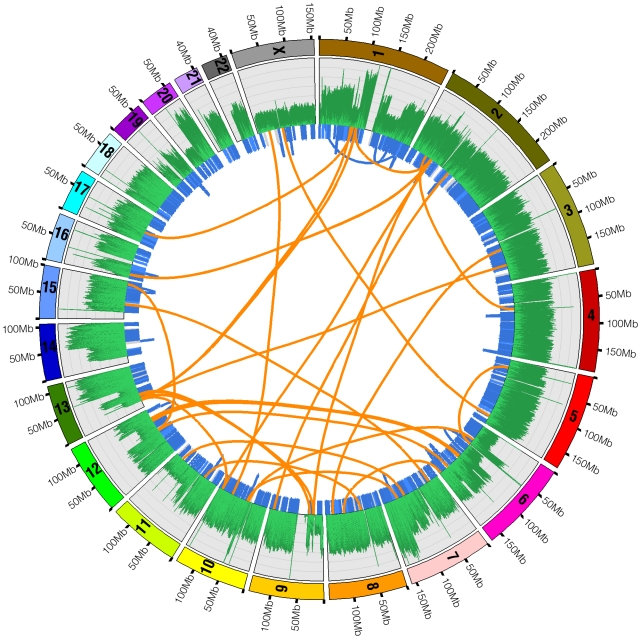
Structural variations in U87MG.Structural variations detected by whole genome sequencing in the U87MG genome are plotted in the Circos program. Orange lines linking two chromosomes represent the 35 interchromosomal translocations. Blue lines around the edge of the circle represent microdeletions and intrachromosomal translocations. The outermost histogram represents sequence coverage and demonstrates how the boundaries of changes in coverage typically coincide with a significant structural variation.